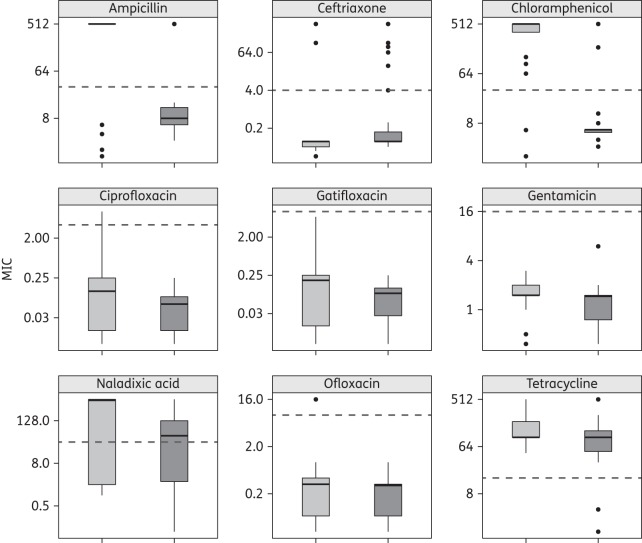
MICs (mg/L) of a range of antimicrobials for the Shigella isolates in this study (log2 scale). Box plots show the median (black line across each box) and the 5th and 95th percentiles. MICs for S. sonnei are shown in dark grey and MICs for S. flexneri are in light grey. The broken line in each plot represents the current CLSI breakpoint for resistance.11